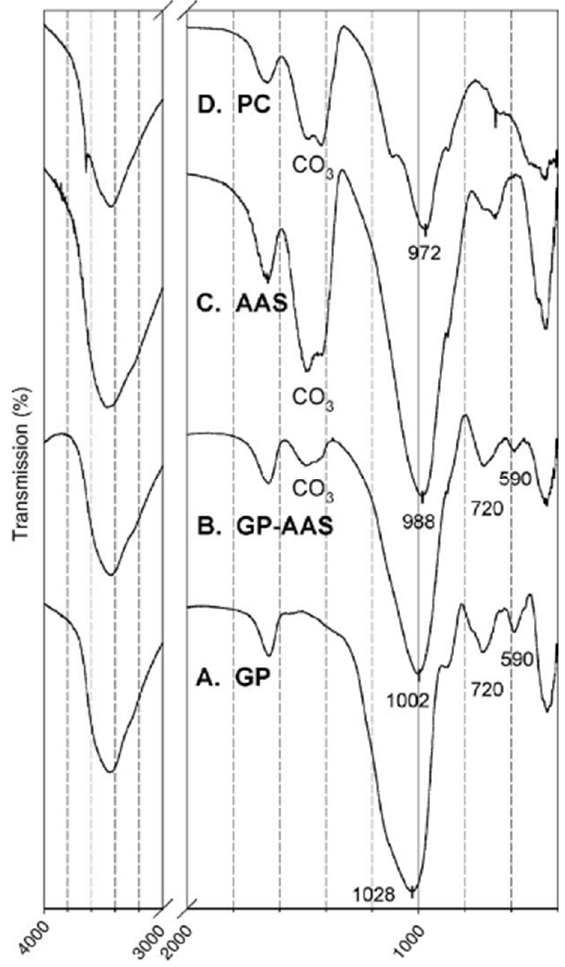
Figure 5. Vibration bands in OPC, AAS, and geopolymer binders (From Elsevier Ref. [63] and used with copyright permission).